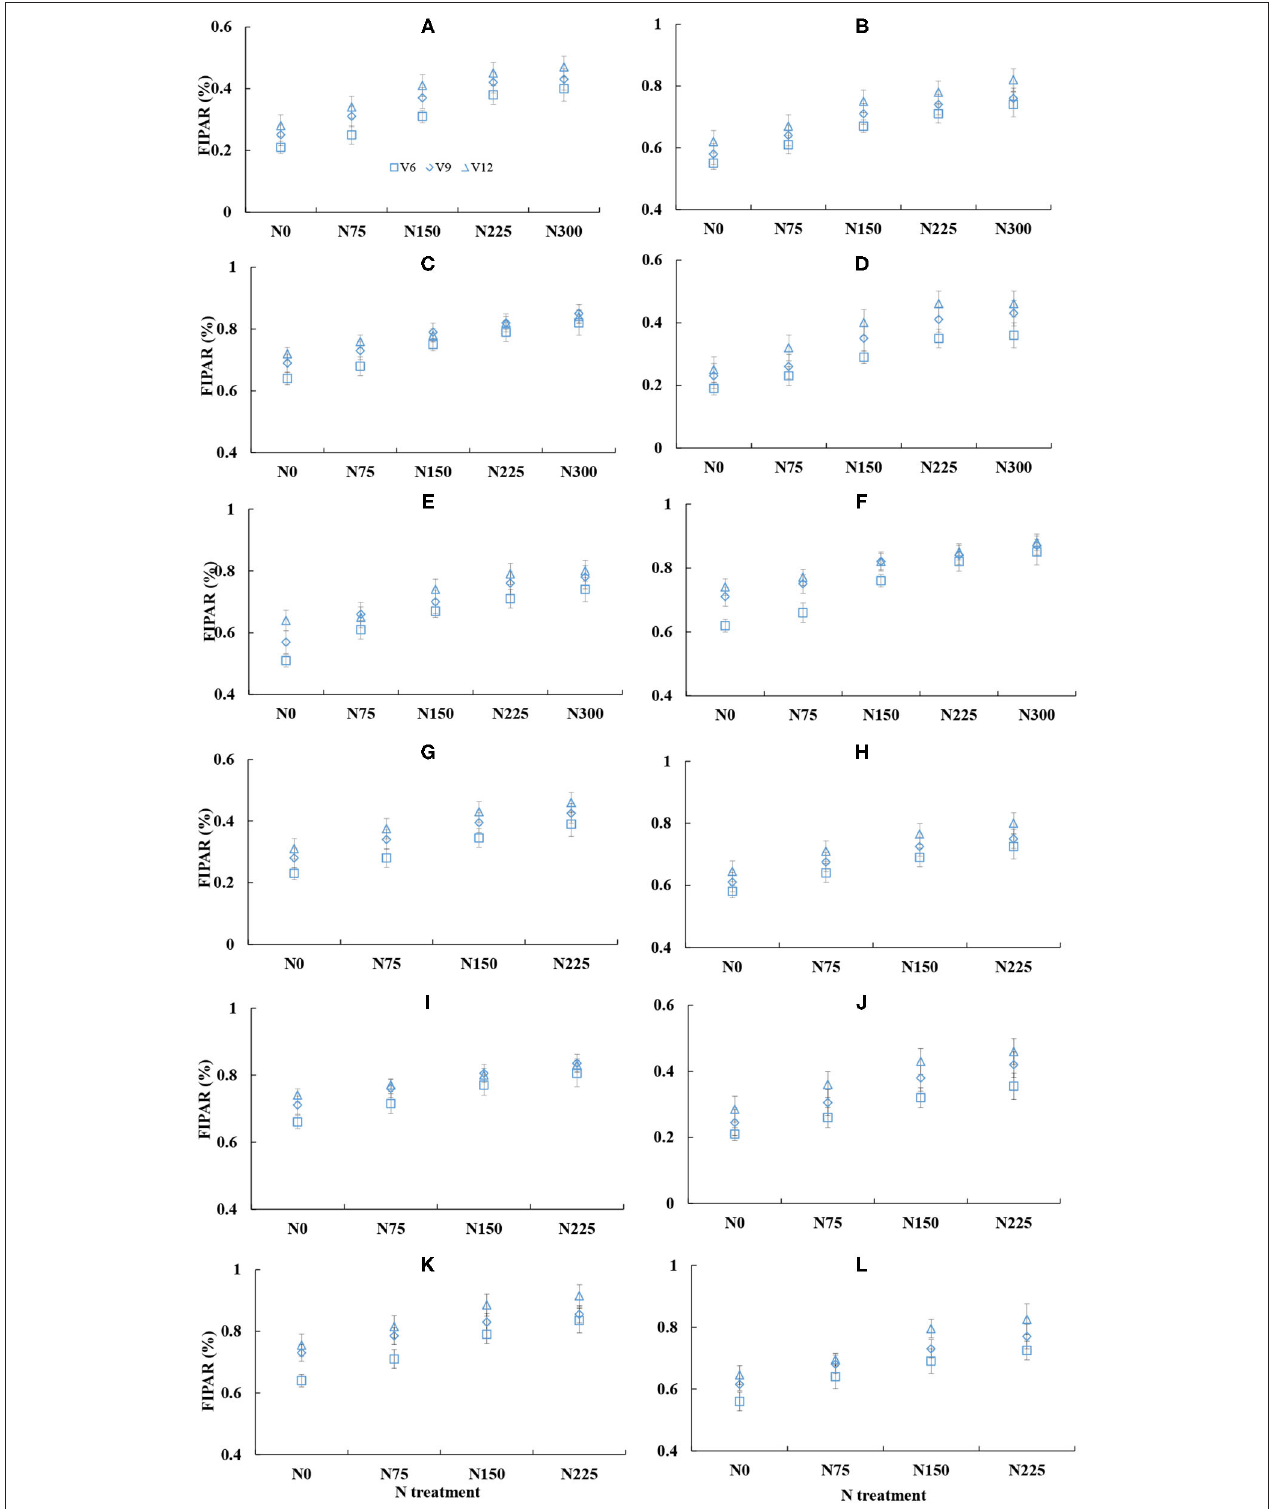
FIGURE 7 | Changes in the fraction of intercepted photosynthetic active radiation (FIPAR) under the different leaf layers across various nitrogen (N) treatment from V6 to V12 stages of corn during the 2015–2016 growing seasons ( A : 2015 DY919 L1; B : 2015 DY919 L2; C : 2015 DY919 L3; D : 2015 JD20 L1; E : 2015 JD20 L2; F : 2015 JD20 L3; G : 2016 DY919 L1; H : 2016 DY919 L2; I : 2016 DY919 L3; J : 2016 JD20 L1; K : 2016 JD20 L2; L : 2016 JD20 L3. V6, V9, and V12 represent the sixth, ninth, and twelfth leaves, respectively).